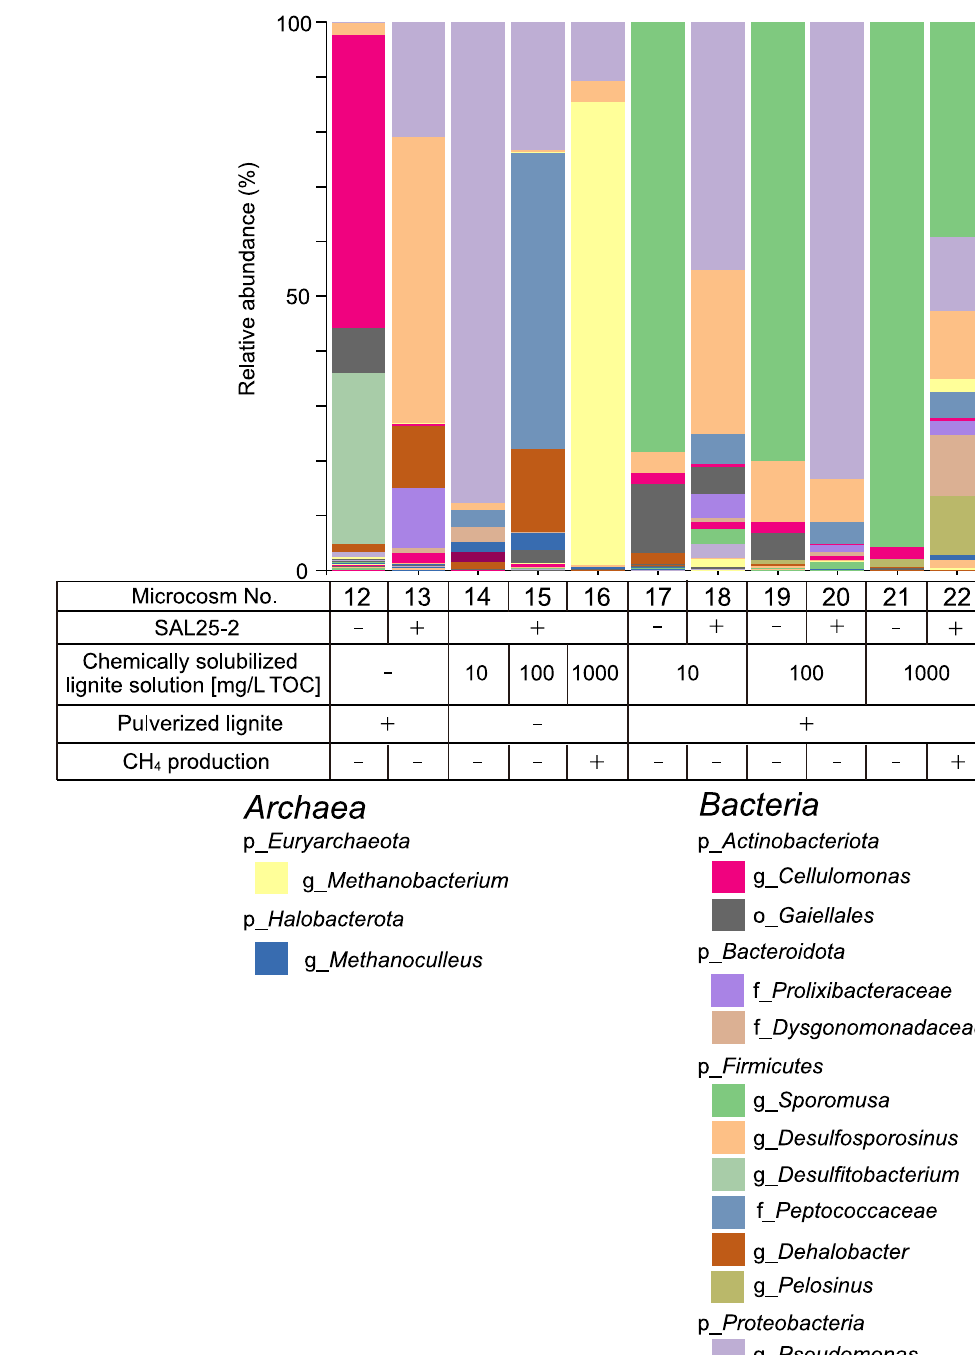
Figure 5. Microbial community structure of each microcosm experiment using SAL25-2. Microcosm numbers correspond to those in Supplementary Tables S4 and S7. Major taxonomic groups with a relative abundance of >c.a. 1.0% were indicated. The methane production results were confirmed in Figure 4. p_, Phylum level; o_, Order level; f_, Family level; g_, Genus level. − , not added or absent; +, added or present.